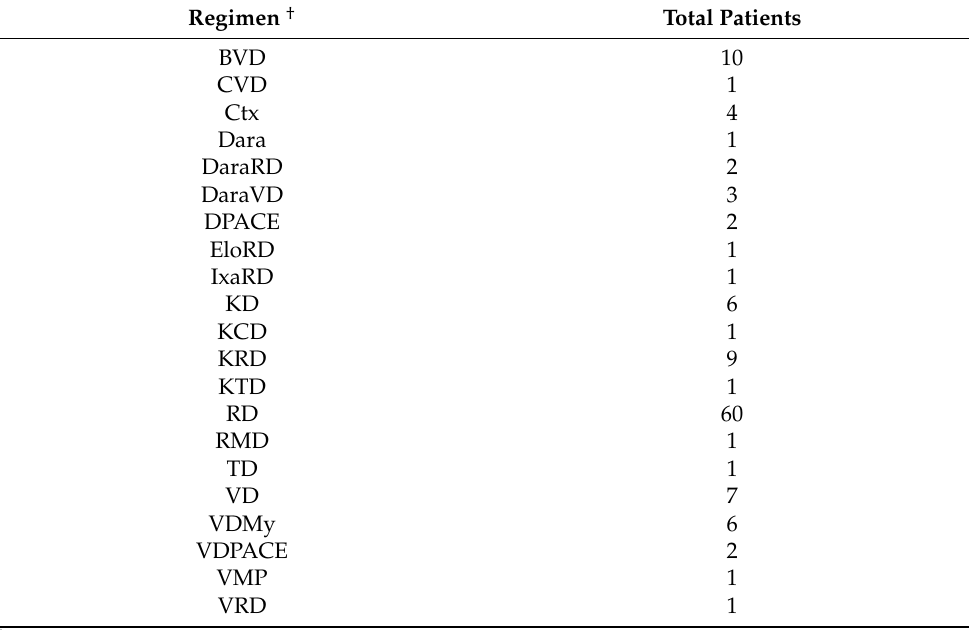
Table 2. Previous-line treatments.